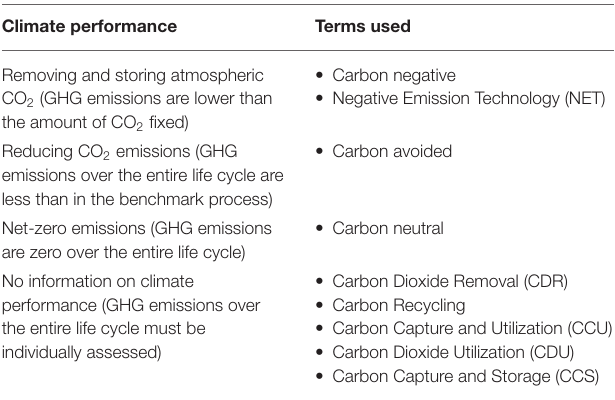
TABLE 2 | Classification scheme for climate performance of technologies. Climate